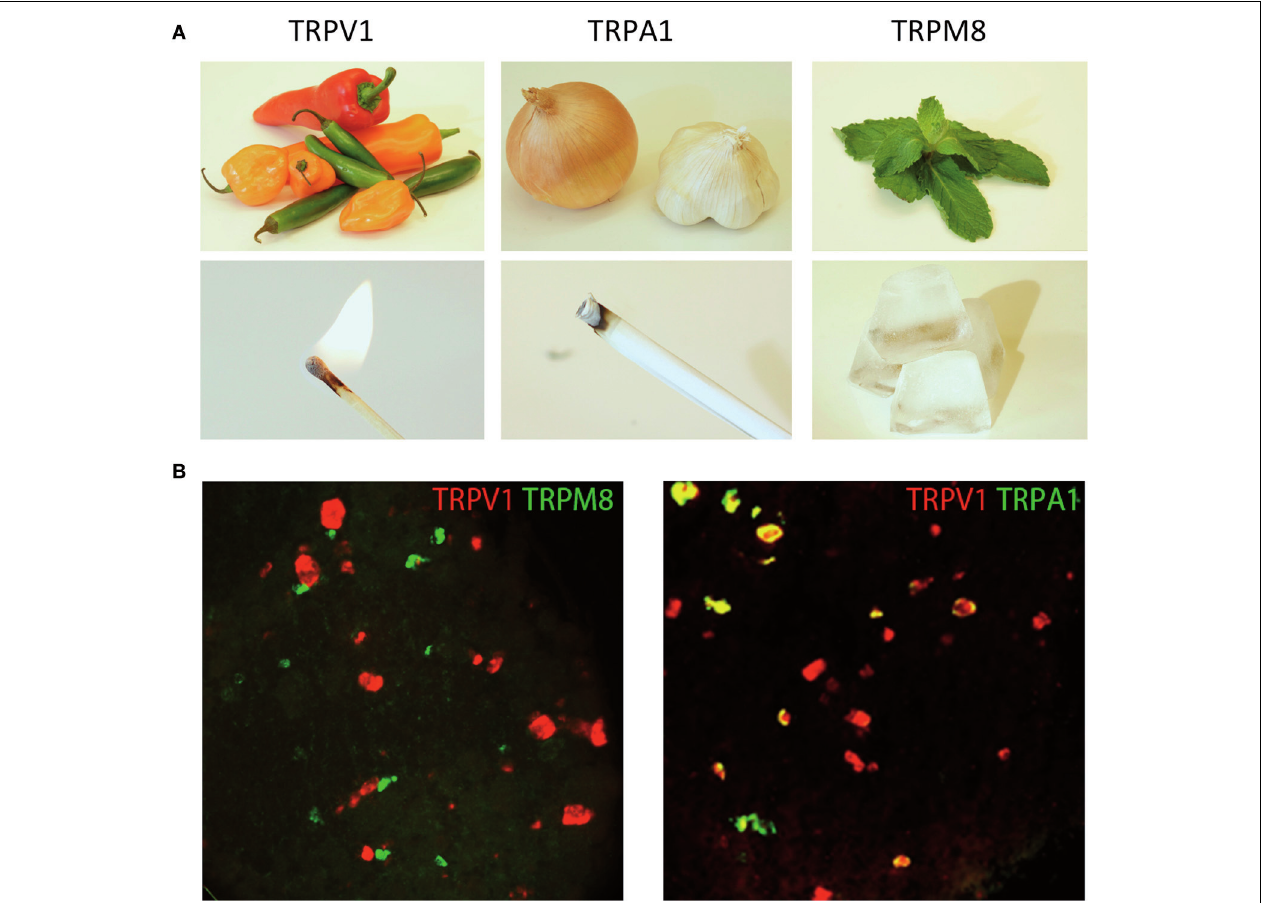
FIGURE 2 | TRP channels respond to unique types of stimuli. (A) Natural products from chili peppers, onions/garlic, and mint leaves selectively activate TRP channels (TRPV1, TRPA1, and TRPM8, respectively). The psychophysical effects of these compounds directly correlate with the environmental stimuli to which these TRP channels are responsive. Activation of TRPV1 by either capsaicin from chili peppers or heat evokes a burning sensation, activation of TRPA1 by mustard oil and